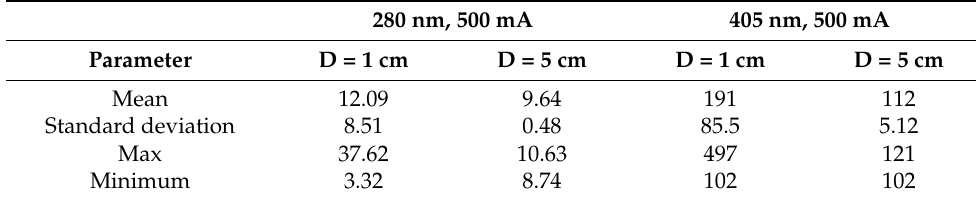
Table 2. Statistics of light intensity (mW/cm 2 ), as received by the Petri